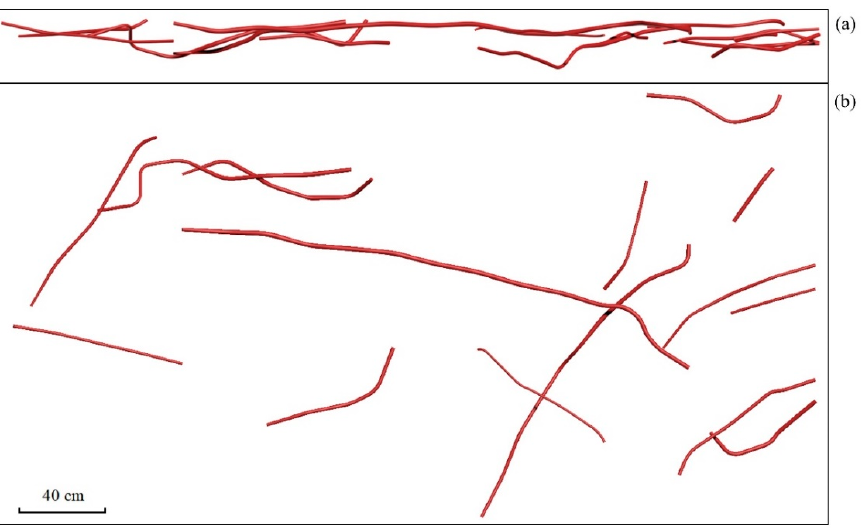
Figure 11. Front ( a ) and ground plan ( b ) views of the reconstructed 3D root system architecture (RSA) of moso bamboo. This 3D RSA was developed using the topology structure presented in Figure 10. Figure 12 shows a comparison of the actual measured RSA topology (red dashed line) with the GPR-based reconstructed topology (black solid line), constructed using the best scoring function. The reconstructed topology is mostly consistent with the measured to- pology, although subtle spatial shifts are present. It should also be noted that some root points are not present in the reconstructed topology. Figure 13 shows a comparison of the actual measured 3D RSA (red) with that (green) reconstructed based on GPR analysis. The reconstructed RSA provided a rough approximation of the measured RSA, with the re- construction exhibiting some deviation from the actual measured RSA due to missing root points and rhizome displacement. The GPR-based reconstructed RSA estimated the total length, volume, and biomass of the root system at an accuracy of 64.45%, 73.21%, and 72.84%, respectively (Table 4). Figure 12. Comparison of actual measured (red dotted lines) and reconstructed (black solid lines) topology of the rhizome system. The measured root system architecture (RSA) topology was ob- tained by directly connecting the measured root points (red circles), while the ground-penetrating radar (GPR)-based RSA topology was constructed by connecting the root points detected by GPR (black circles).